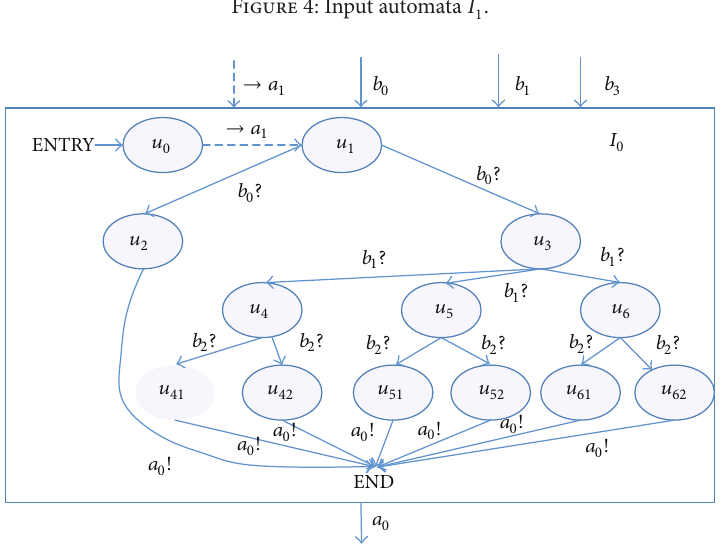
Figure 4: Input automata 𝐼 1 .